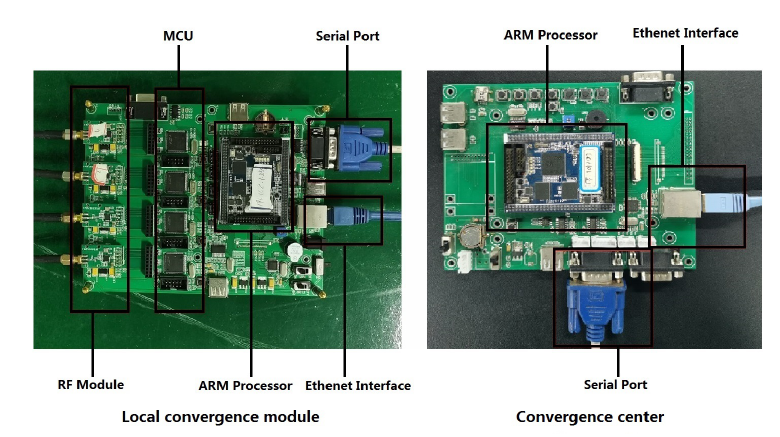
Figure 6. Local convergence module and convergnence center.